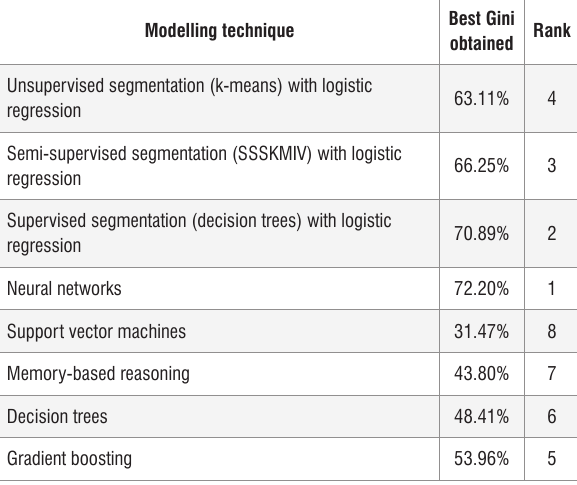
Credit application data set: Comparison of performance Modelling